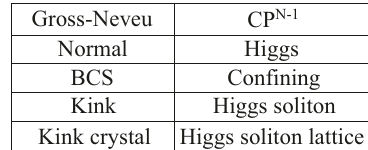
Table 1 . The correspondence between the previously known solutions in the GN model and those in the C P N (cid:0) 1